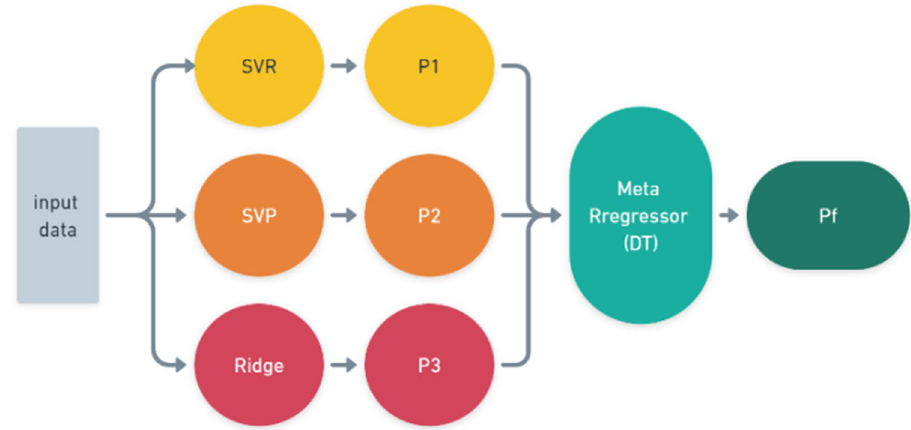
Fig. 5 Determined structure for the Stacked Regression